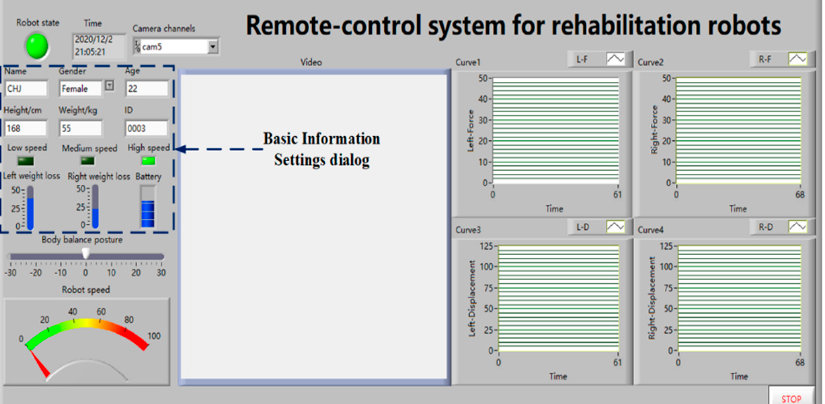
Figure 15. Dialog interface of basic information.